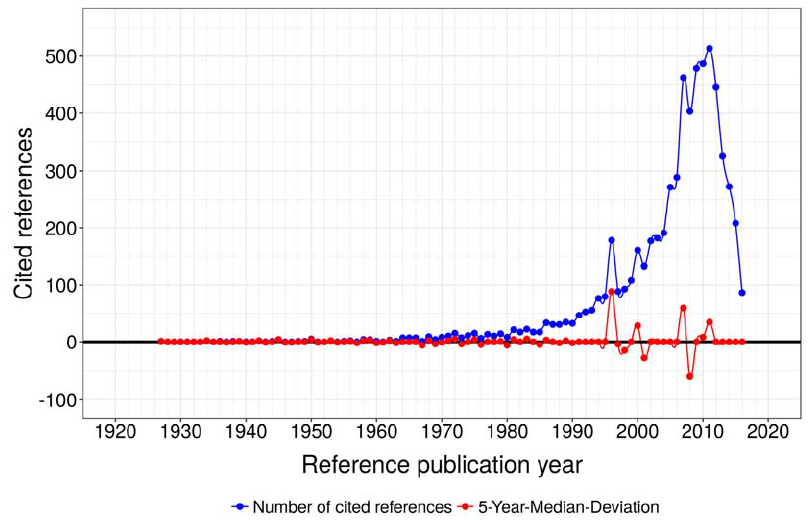
Figure 2. Annual distribution of the references cited in the publication set of 84 papers across their reference publication years 1927–2016. Blue curve: number of cited references; red curve: deviation from the median.